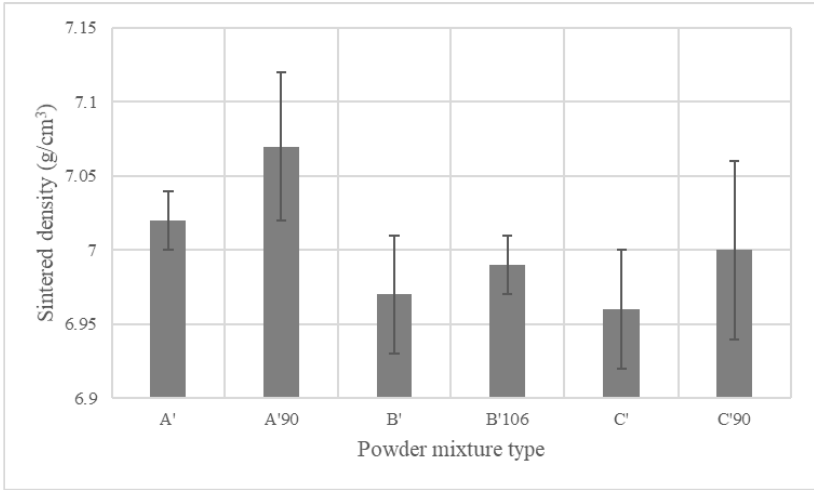
Figure 11. Density of standard transverse rupture strength (TRS) samples prepared from various PMS mixtures (including 0.7 wt. % of a lubricant).